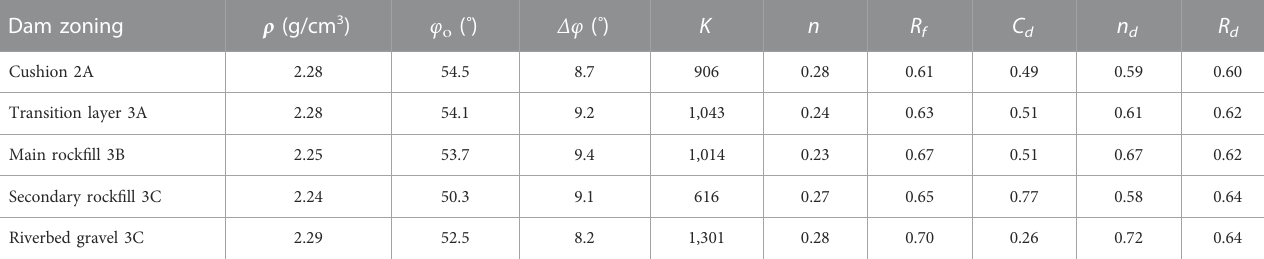
TABLE 1 The Nanshui model ’ s parameters of the dam ’ s material. Dam zoning